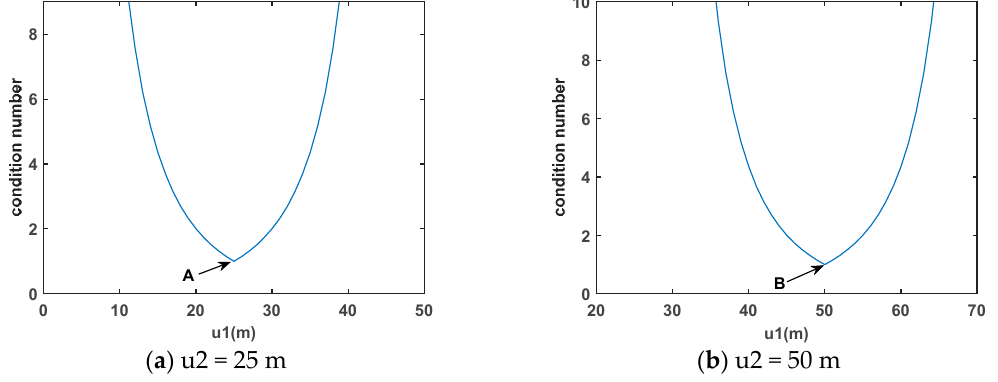
Figure 3. The slice graph of Figure 2.